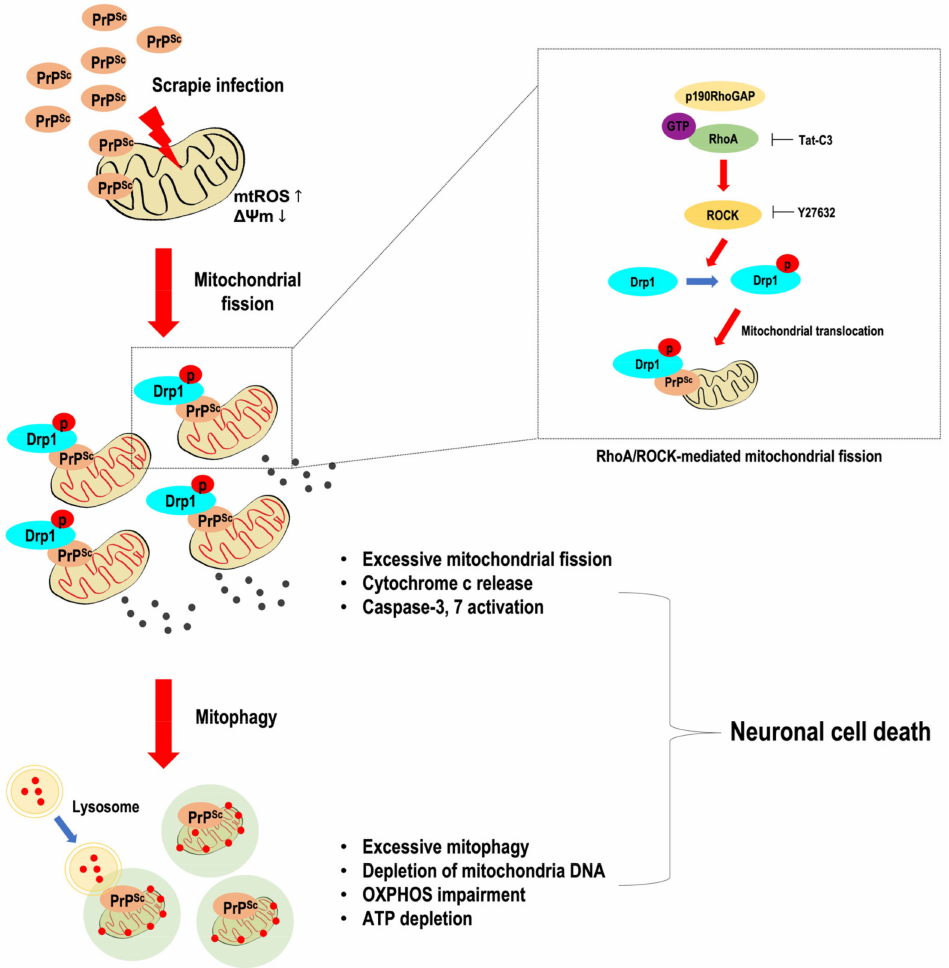
Figure 7. Schematic representation of PrP Sc -mediated neuronal cell death through mitochondrial dysfunction. Scrapie infection increased the phosphorylation of Drp1 at serine 616 in the mitochondria via RhoA/ROCK activity, leading to the activation of mitochondrial fission, accompanied by excessive mitophagy. Moreover, scrapie infection also increased cytochrome c release from the mitochondria and reduced mitochondrial function. Subsequently, excessive mitochondrial fission and mitophagy resulted in enhanced caspase 3 activity and PARP cleavage and hampered ATP production by impairing OXPHOS, facilitating neuronal cell